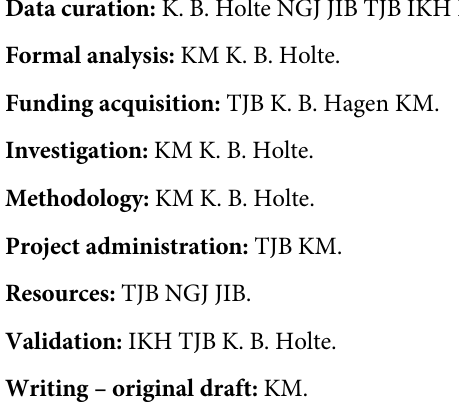
S1 Fig. Equations for calculating Mean Time-Weighted HbA and Full Duration Mean Time-Weighted HbA (DOCX) S1 Dataset. Minimal data set underlying the findings in the study.